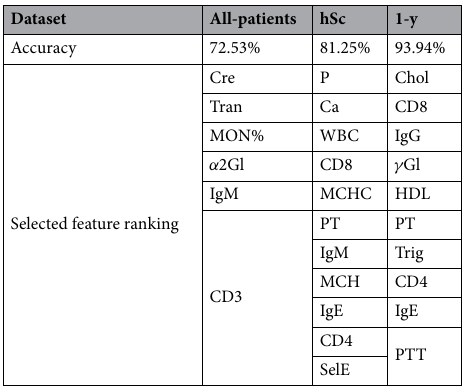
Table 3. List of the most informative features selected by the SVM-RFE for each ALS/LMND